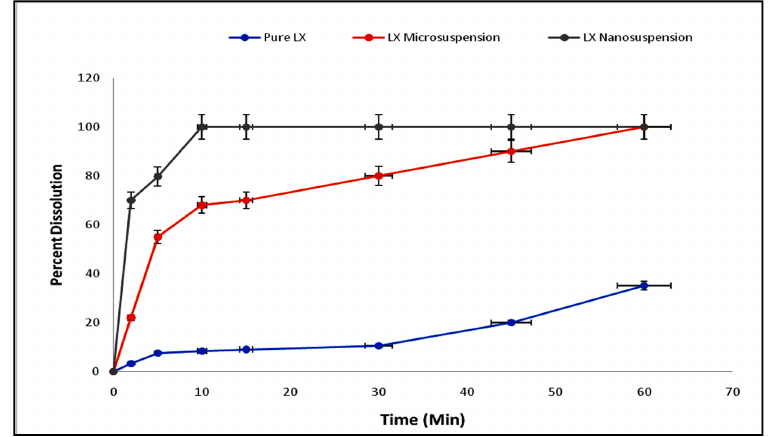
Figure 5. Comparative dissolution studies of pure LX, microsuspension of LX, and nanoemulsion of LX.